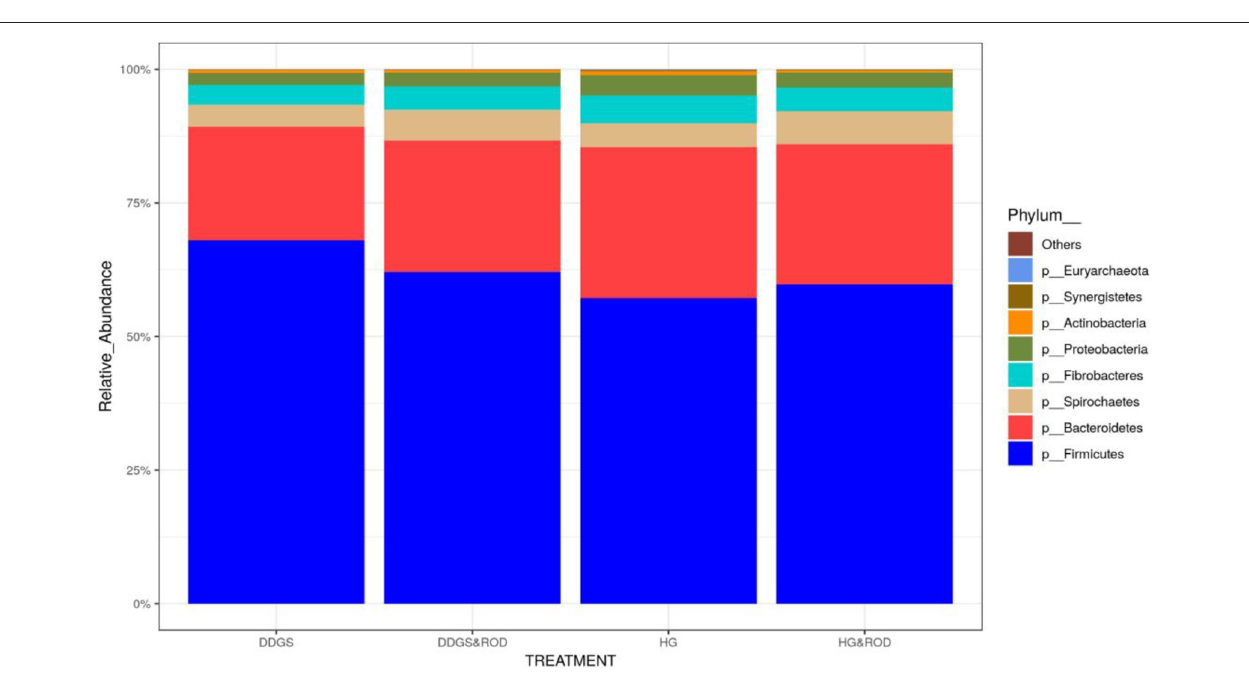
FIGURE 3 | Effect of different treatments on the relative abundance (RA) of the ruminal microbial community at the phylum level. Treatments were as follows: wheat DDGS diet without adding the ROD extract; DDGS&ROD (wheat DDGS diet with ROD extract); HG (basal diet without adding ROD extract); and HG&ROD (basal diet with ROD